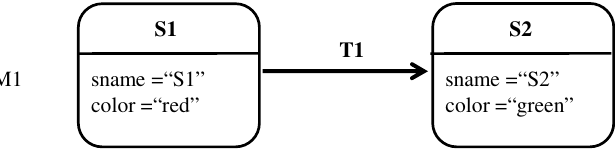
Figure 14. First version of a state transition diagram,